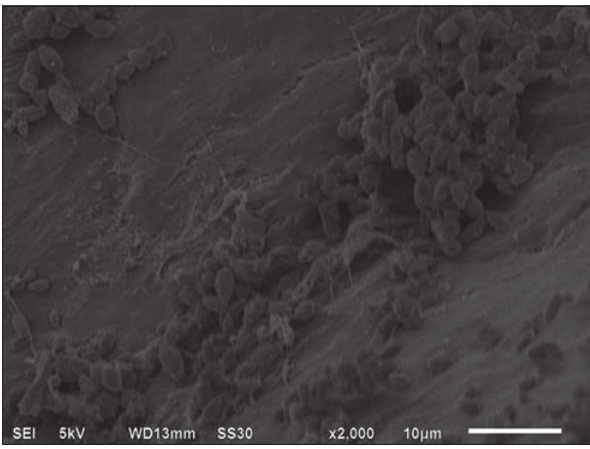
Figure-5: Attachment and proliferation of goat bone marrow-derived cells over acellular swim bladder by day 7 (scanning electron microscopy observation, ×2000).